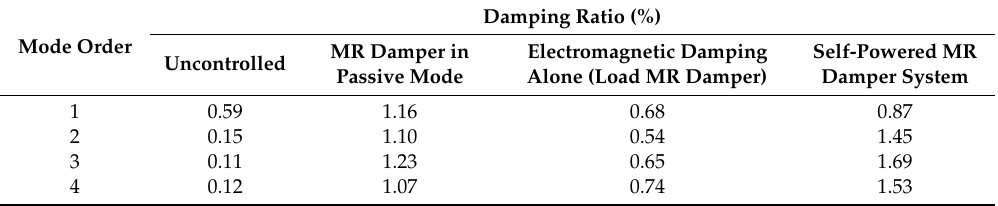
Table 4. Comparisons of modal damping ratios of the cable with different control devices.